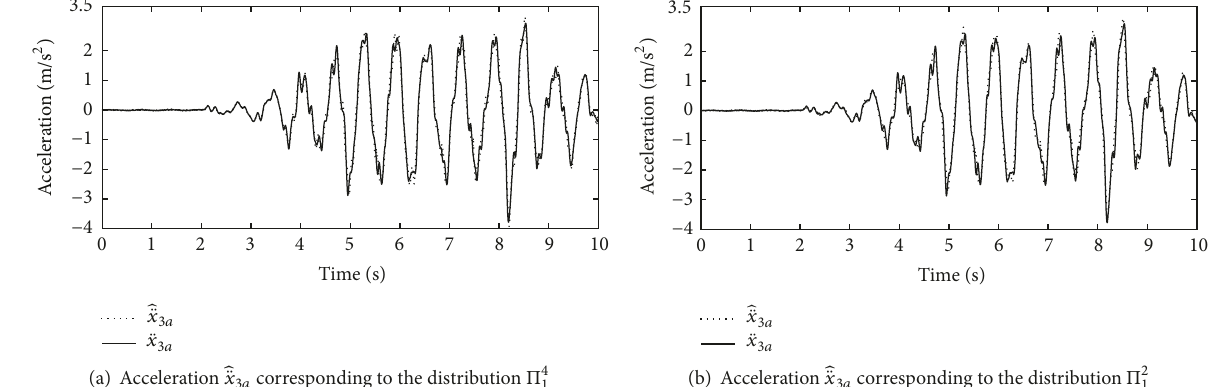
(b) Acceleration ̂̈𝑥 3𝑎 corresponding to the distribution Π 2 1